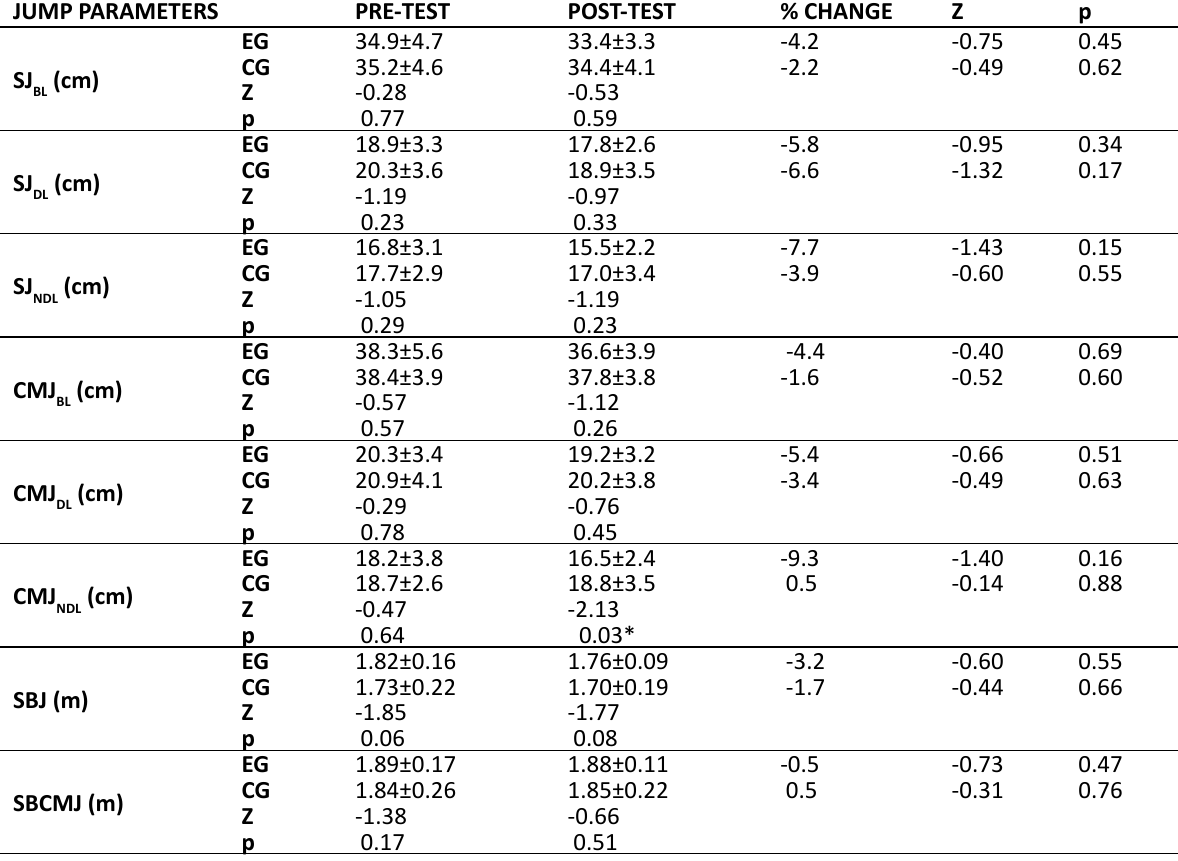
Table 2. Pre- and post-test results of vertical and horizontal jump parameters JUMP